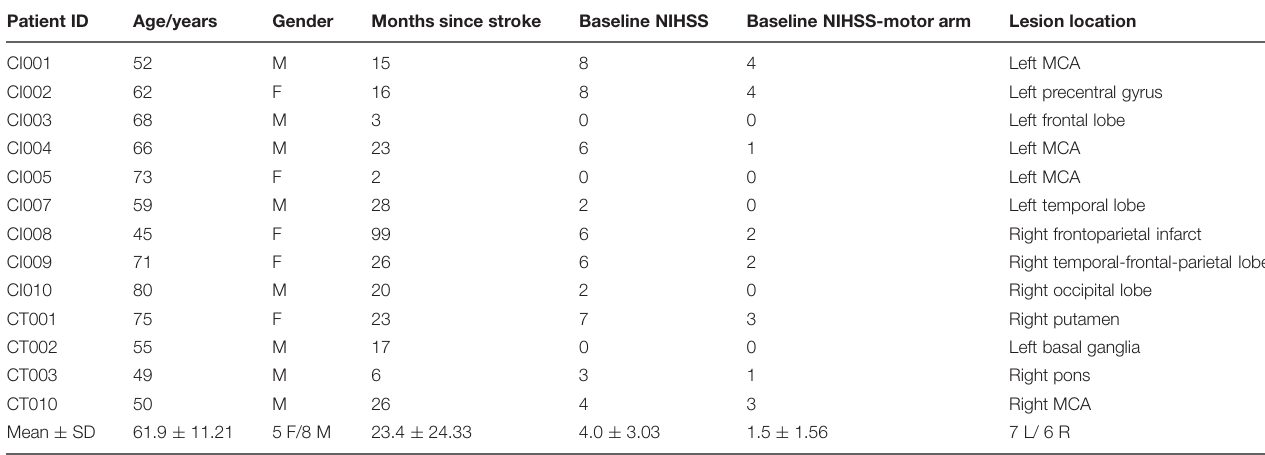
TABLE 1 | Patient